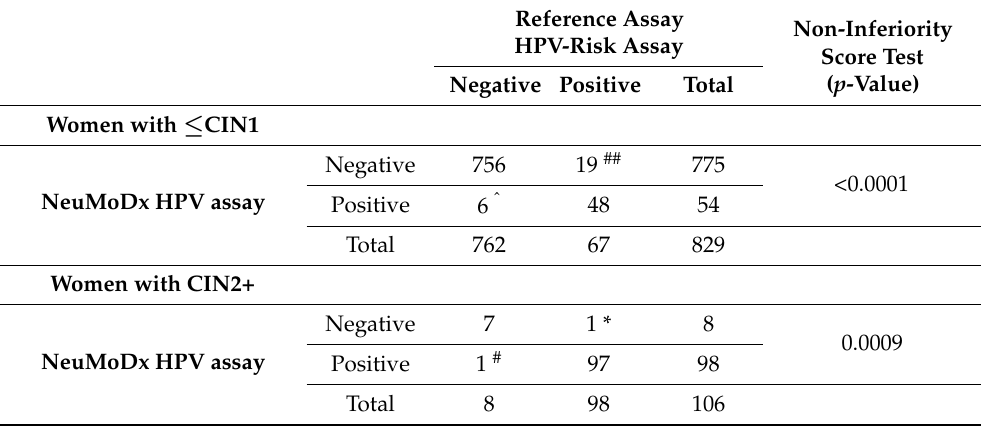
Table 5. Clinical performance for CIN2+ of NeuMoDx HPV assay as compared to HPV-Risk assay on SurePath collection medium (group